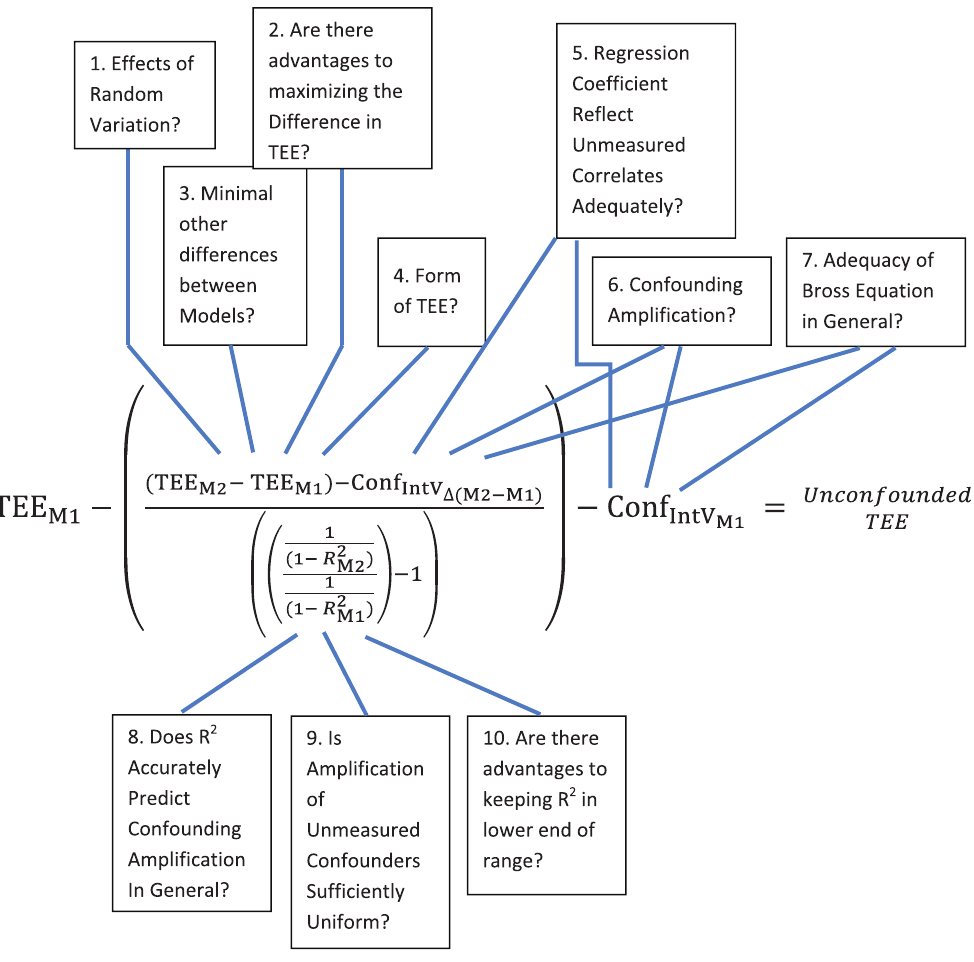
Appendix Figure 1b. ACCE Method Summary Equation Annotated with Key Uncertainties. Abbreviations for Appendix Figure 1a and